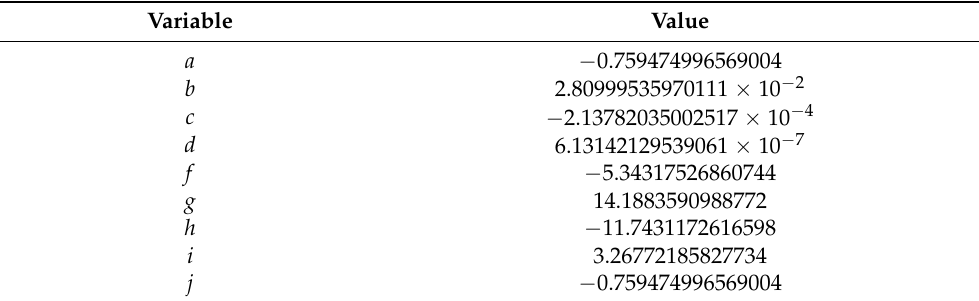
Table 11. Regression variable results for AZ31BF damage map (R 2 = 0.9) for the condition of the 42CrMo4 fit equation type given by Equation